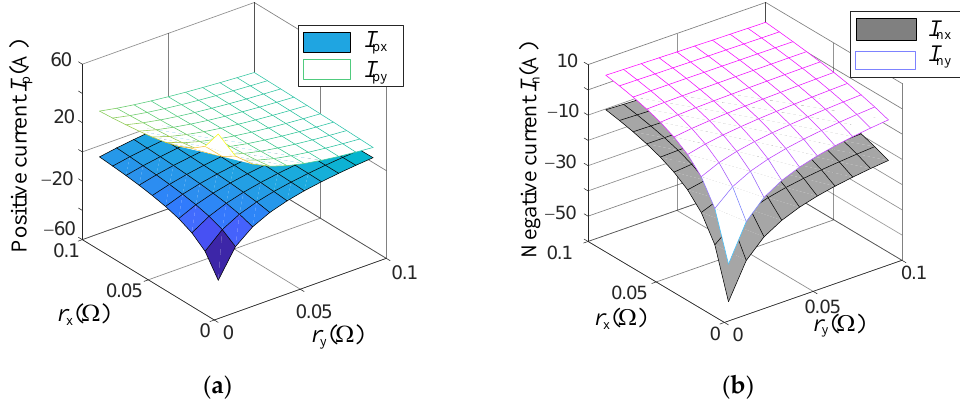
Figure 5. Influence of line resistance on ( a ) positive DC current and ( b ) negative DC current when duty cycles D 1 = 0.45 and D 2 = 0.55.